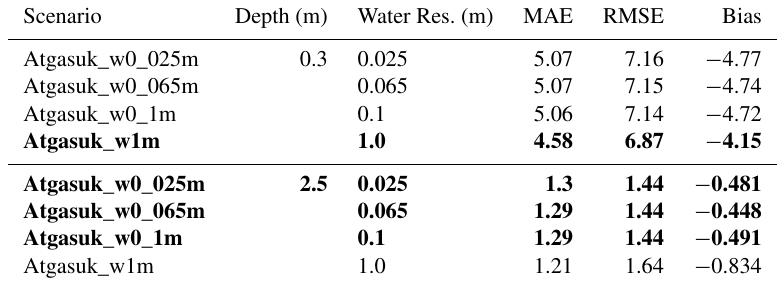
Table D1. Atqasuk modeled water temperature errors calculated from measured water temperature time series at 0.3 and 2.5m across different water vertical resolution simulations. Bold rows are the lowest RMSE for a given water depth. The following variables are included: mean absolute error (MAE), root-mean-square error (RMSE), and mean average error